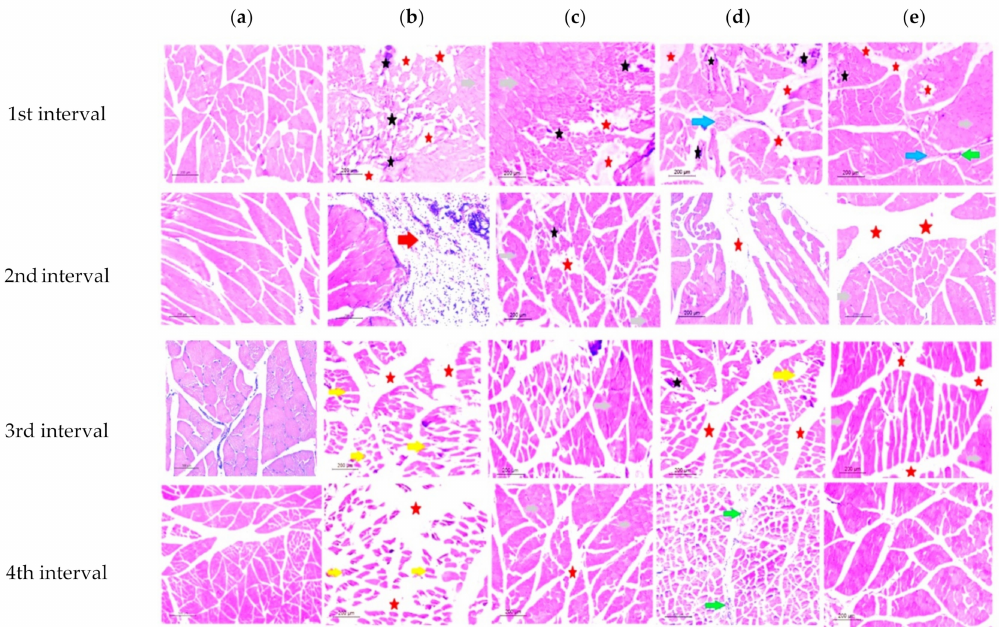
Figure 4. Photomicrographs of transverse section from biceps femoris : ( a ) (control group, group I); ( b ) (infected group, group II); ( c ) (ZnO-NP-treated group, group III); ( d ) (physically trained group, group IV); ( e ) (combined treated group, group V). Cellular infiltrate (black stars); necrotic gaps (red stars); nerve bundles (blue arrow); ischemic muscle fibers (grey arrow); dilated blood vessel (green arrow); Edema (red arrow); atrophic skeletal myocytes (yellow arrow). (Scale bars: 200 µ